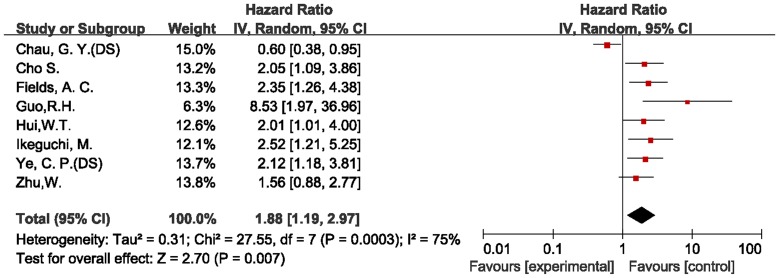
Forest plot of Hazard ratio (HR) for disease-free survival (DS) of HCC patients.Highly significant heterogeneity can be found before Chau GY’ study was excluded.